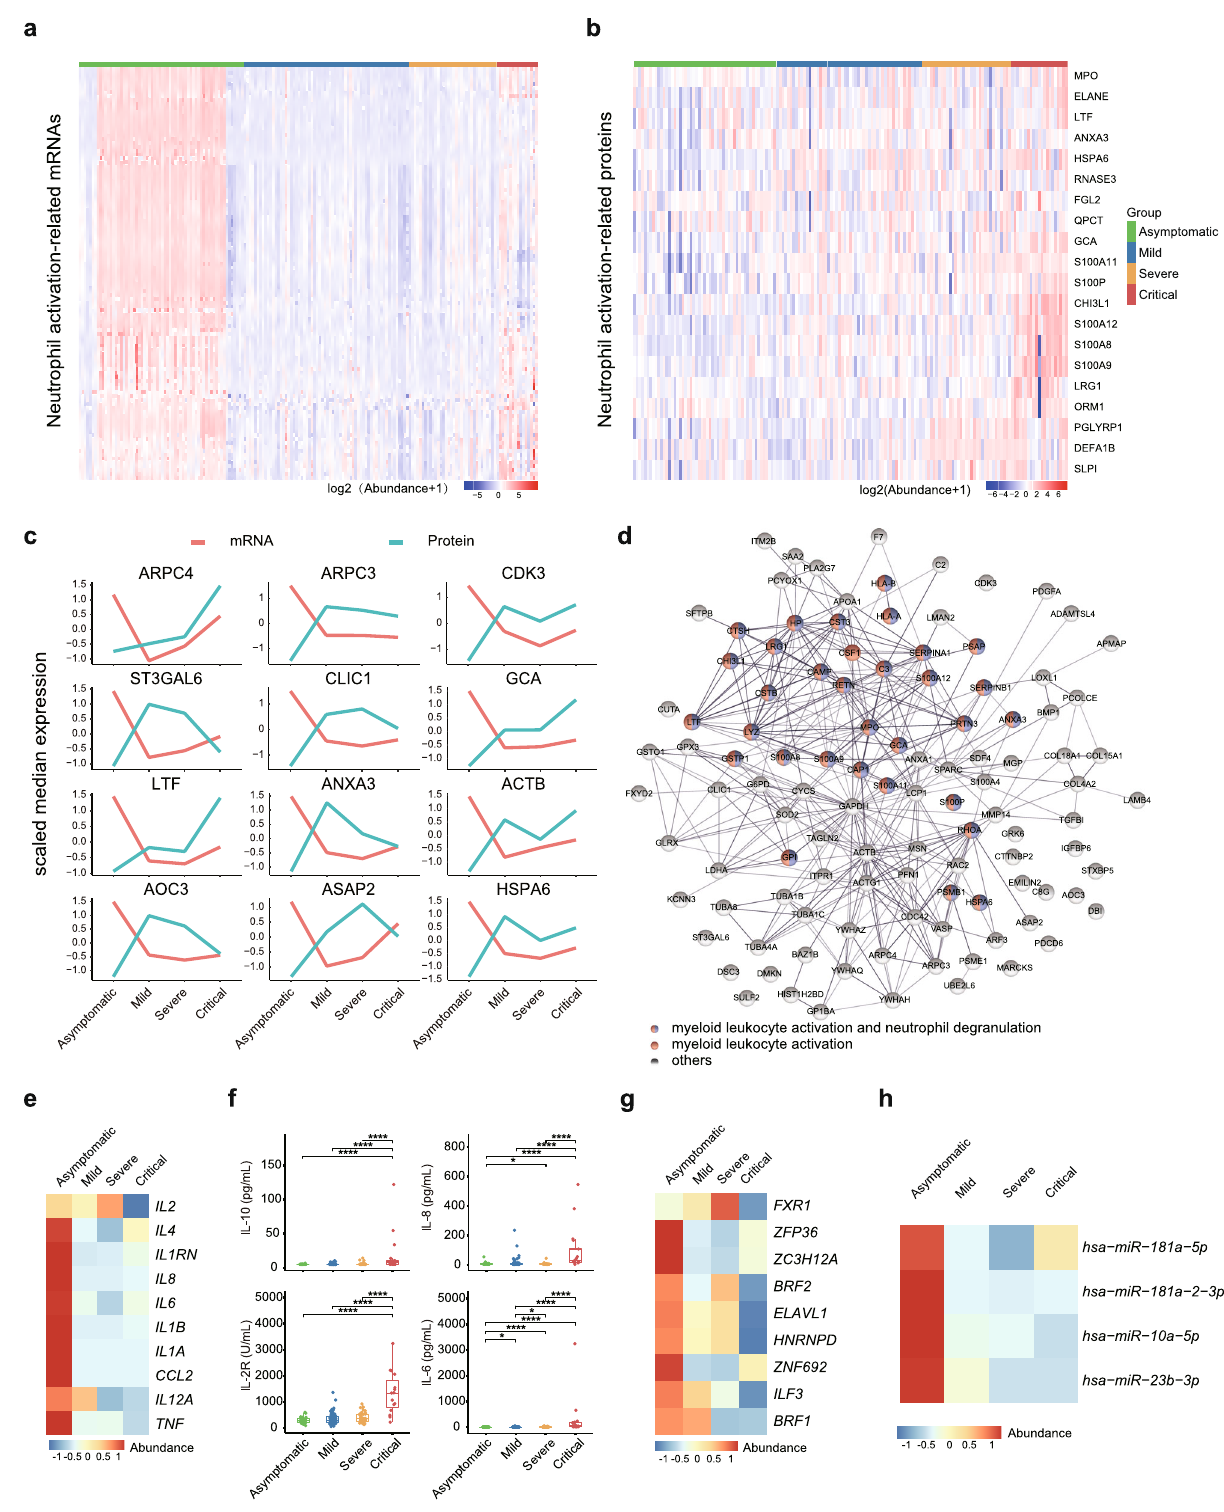
T cell depletion in critically ill COVID-19 patients accords with the clinical observation of T cell lymphopenia 73 . Recent research has demonstrated that SARS-CoV-2 infection dramatically reduces T cells and up-regulates exhaustion markers PD-1 and Tim-3, especially in critically ill patients 73 . Mechanistically, clinical evidence shows that T cell counts are negatively asso- ciated with serum IL-6, IL-10, and TNF- α concentrations 73 , and